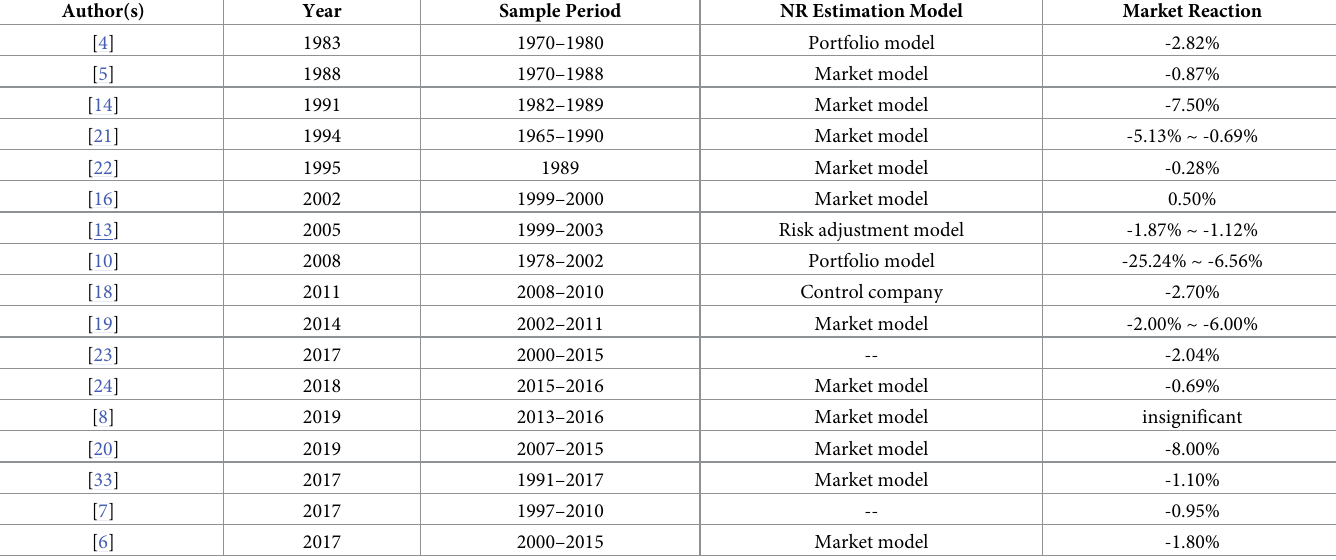
Table 1. Summary of prior studies on the market reaction to listed companies’